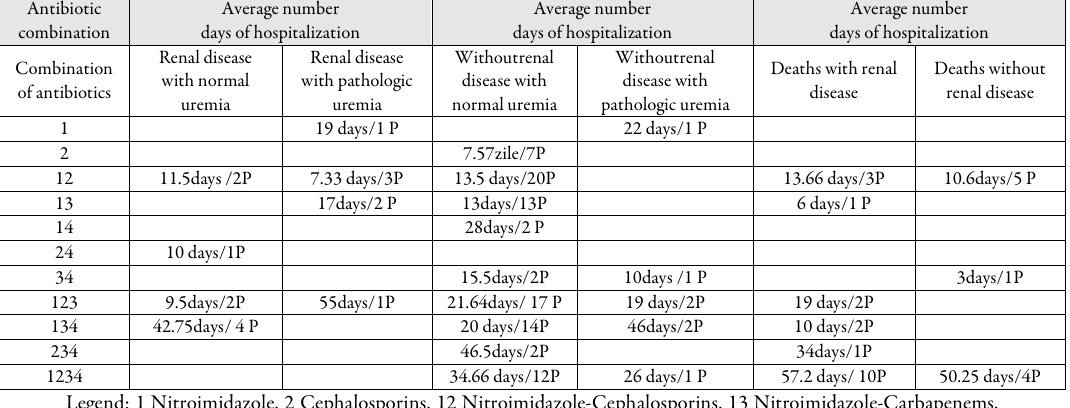
Figure 8. The variation of the number of days of hospitalization according to antibiotic resistance, where BR = kidney disease, FBR = without kidney disease, FBR nitrogen VP = without kidney disease with pathological values of urea, BR nitrogen VP = kidney disease with pathological values of urea, DFBR = deceased without renal disease, DBR= deceased with renal disease The average number of days of hospitalization in the studied group was 20,866 +/-20,7831 days. By correlating the combinations of antibiotics administered with the number of patients and the duration of hospitalization, we obtained the lowest average number in the case of combination 13 (Nitroimidazole with Carbapenem), of 6 days, and the highest average number of days of hospitalization in the case of patients who were administered combination 1234 (Nitroimidazole, Cephalosporins, Carbapenems, Glycopeptides) of 57.2 days (Table 7). Table 7. The average number of days of hospitalization correlated with the antibiotic combination